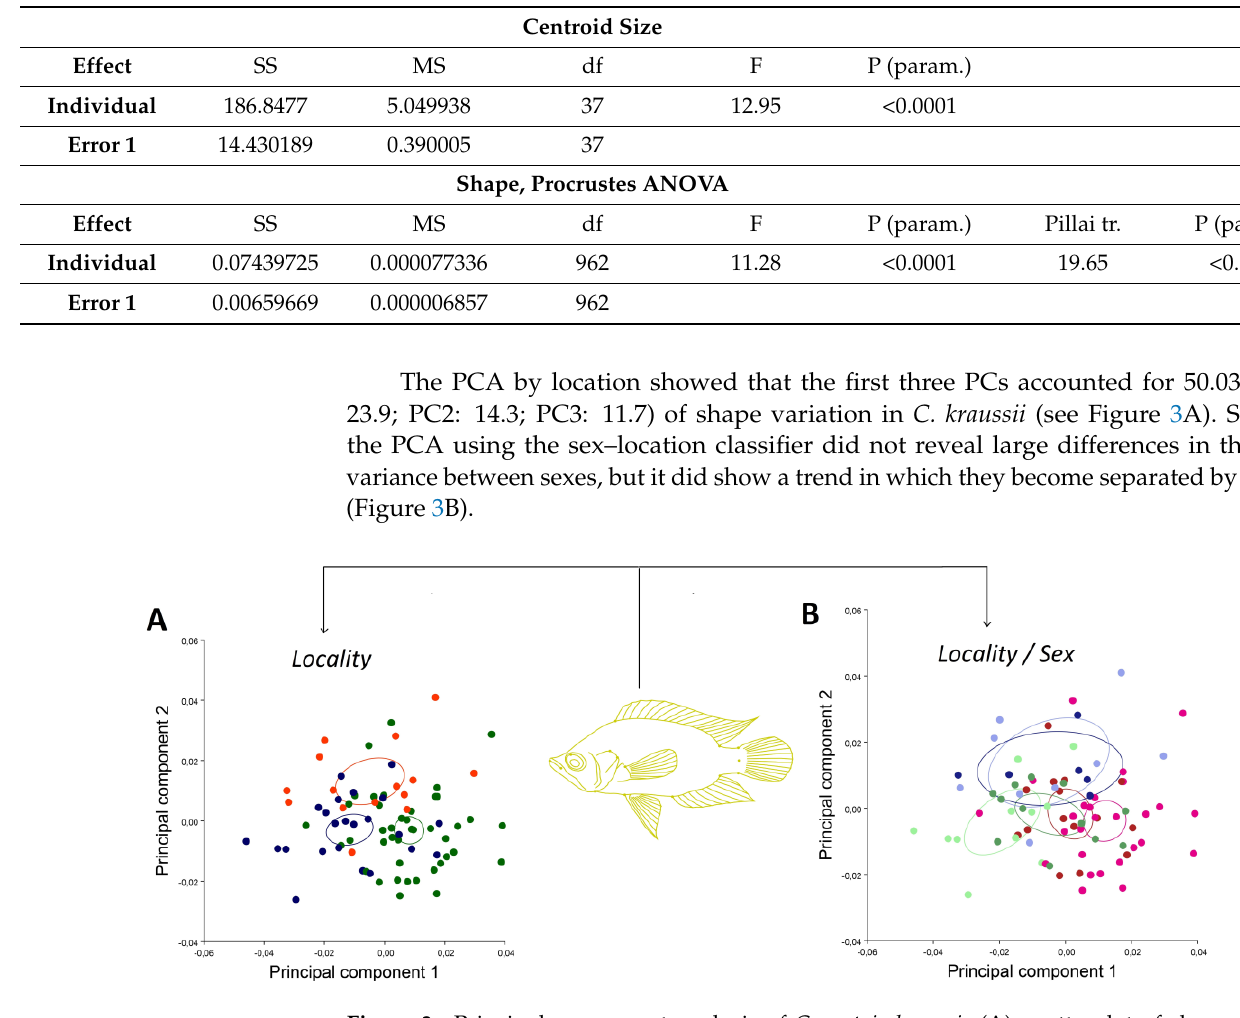
Table 2. Procrustes ANOVA for digitizing measurement error of centroid size and shape of Caquetaia kraussii.